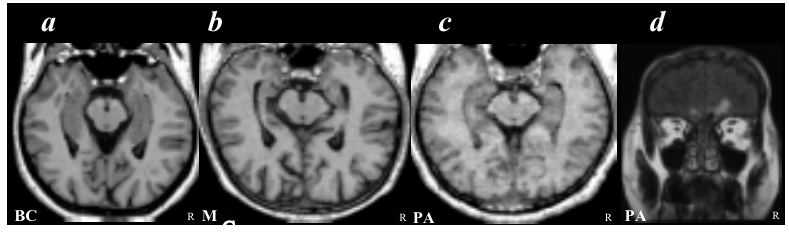
Fig. 1. Axial sections of BC’s, PA’s and MC’s brain centred on the horizontal axis of hippocampi (panels a,b,c ). Coronal section in T2 weighted of PA (panel d